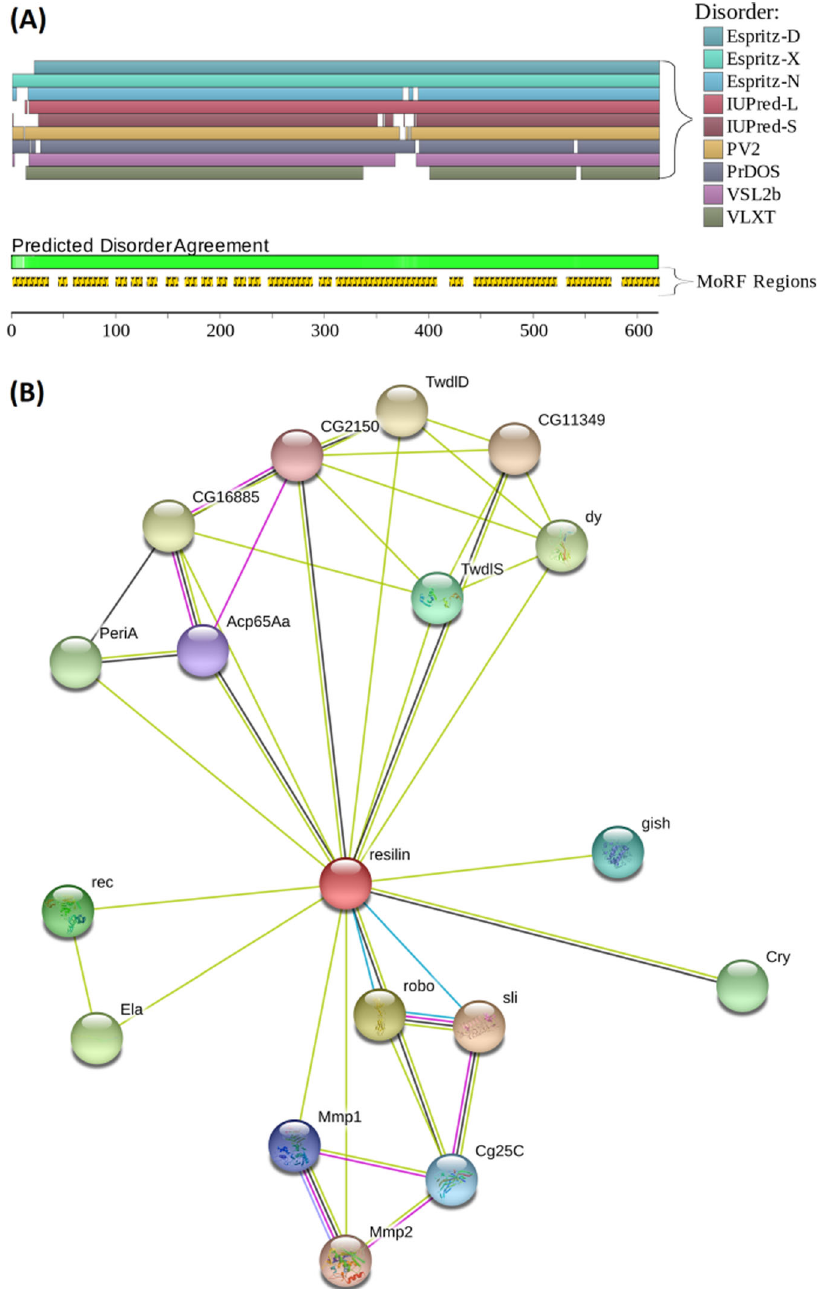
Fig. 2 Evaluation of functional intrinsic disorder propensity and interactivity of D. melanogaster pro-resilin: full-length resilin (UniProt ID: Q9V7U0). a Functional disorder pro fi le generated by D 2 P 2 platform (http://d2p2.pro/) 26 . The nine different coloured bars represent location of disordered regions found by different disorder predictors (Espritz-D, Espritz-X, etc.). The green bar corresponds to disordered regions by consensus, and shows the predicted disorder agreement between these nine predictors. The yellow bar corresponds to disorder-based binding sites known as molecular recognition features (MoRFs). b Interactability of resilin analysed (using the medium con fi dence level of 0.4) by STRING platform (http://string-db.org/cgi/) 27 . The coloured nodes represent query protein (red) and fi rst shell of protein interactors (with gene name or ID), where empty and fi lled nodes represent proteins of unknown 3D structure and some known or predicted 3D structure, respectively. Protein – protein interaction is represented by differently coloured lines, where green line represents neighbourhood evidence, black line represents co-expression evidence, purple line represents experimental evidence and light blue line represent database